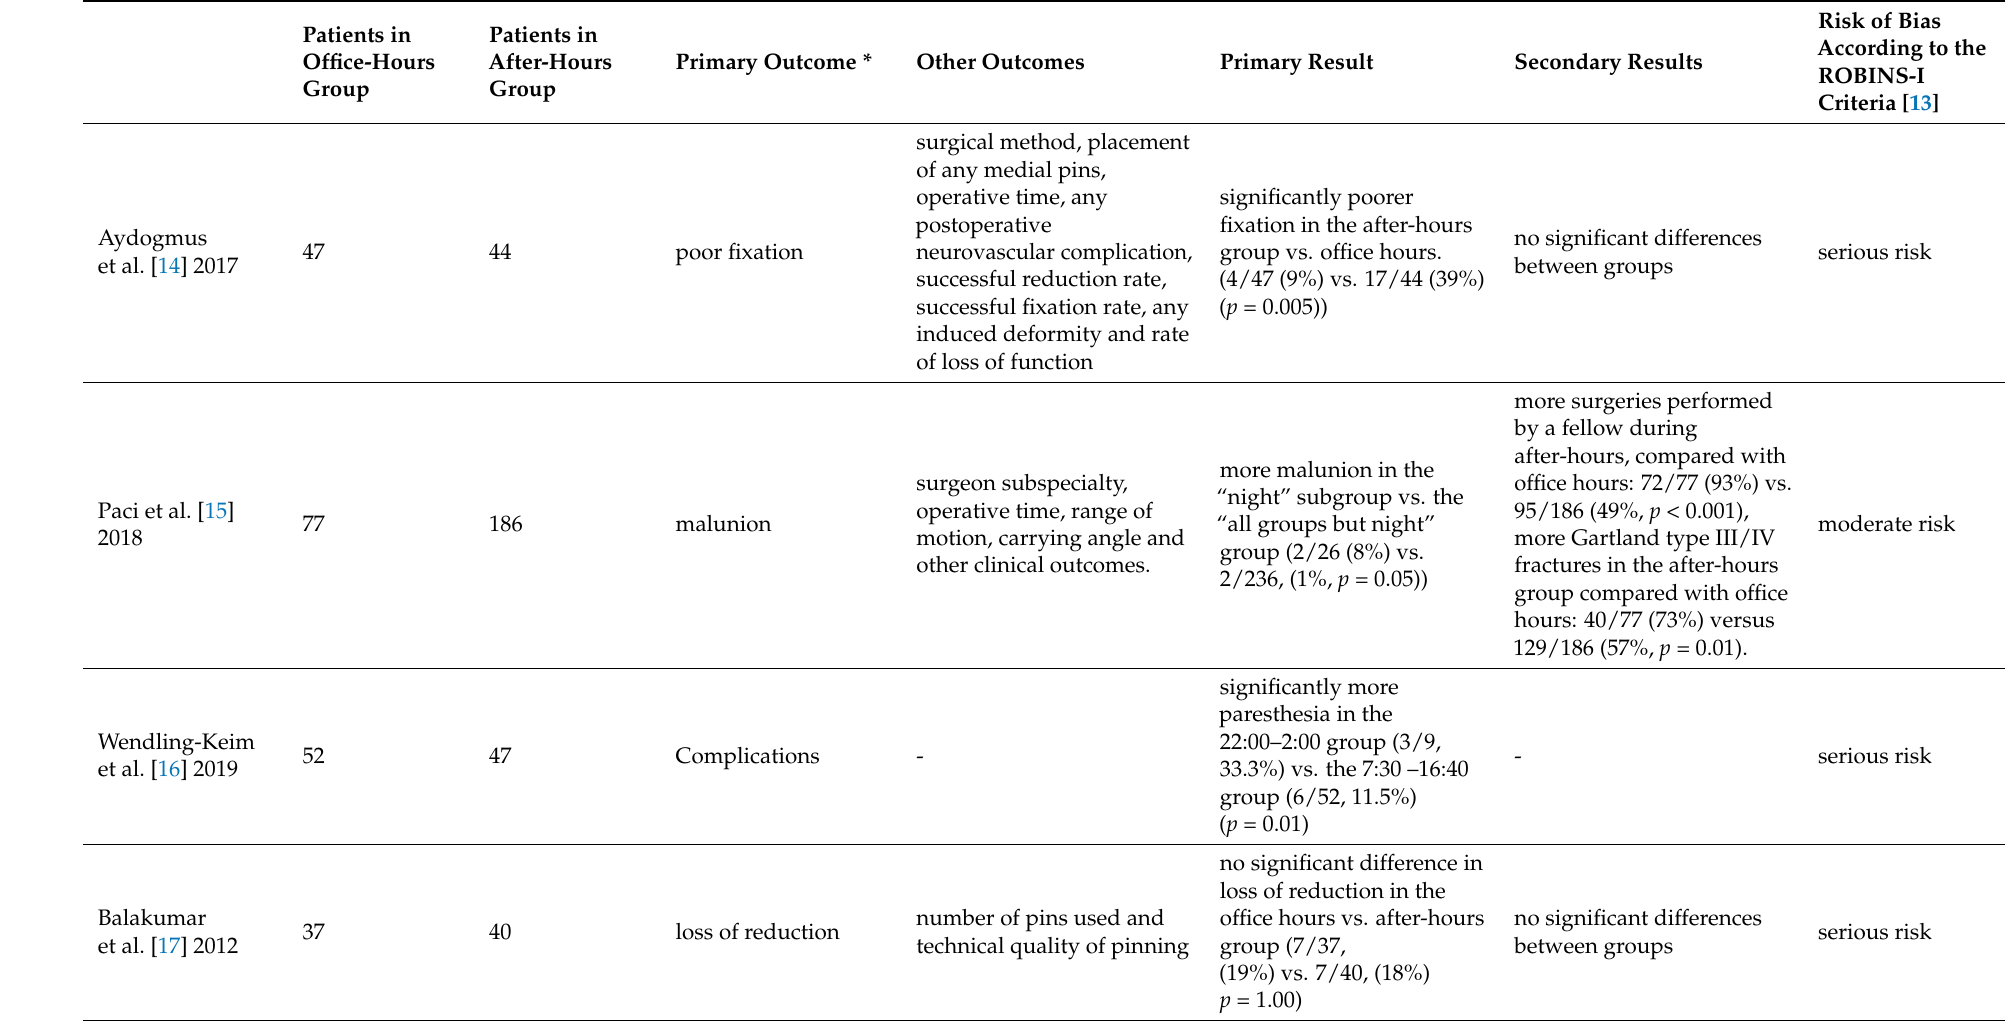
Table 1. Outcomes and results of the included